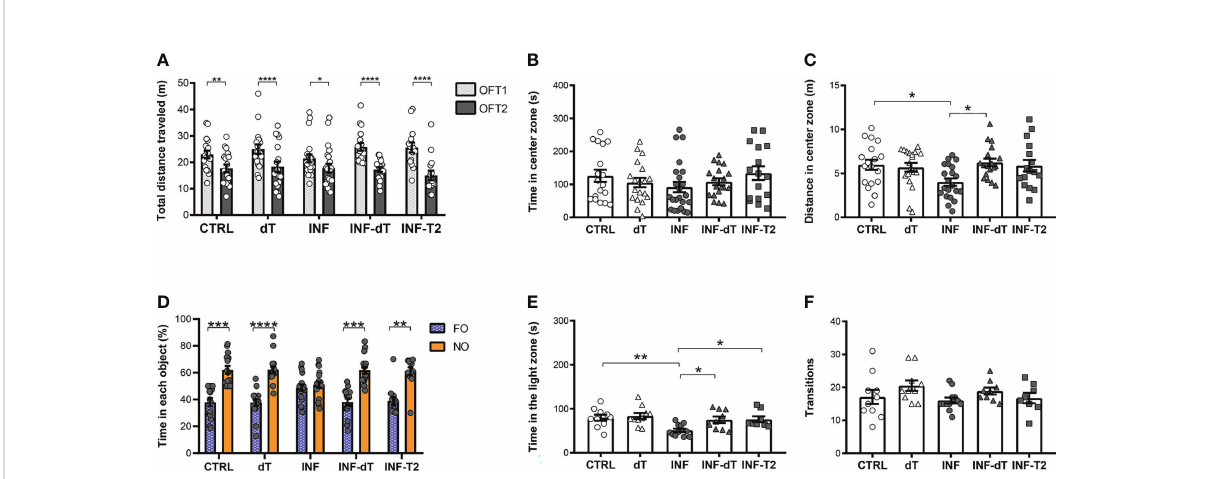
FIGURE 6 Immunization effect on behavioral performance in different paradigms of health mice and after non-severe experimental malaria (control (CTRL), immunized control with dT vaccine (dT), infected (INF), immunized infected with dT vaccine (INF-dT) and immunized infected with T2 stimuli (INF-T2) mice). (A) Total distance traveled in meters (m) in open fi eld test (OFT1 and OFT2). (B) Time in center zone (seconds, s). (C) Distance in center zone (m) in fi rst session of OFT. (D) Time in objects in percentage (%) in test session in the NORT. (E) Time in the light zone (s). (F) Numbers of transitions between light and dark side in light/dark task. Data points are identi fi ed as individuals ’ values. Columns represent mean ± S.E.M. Two-way RM ANOVA/Bonferroni was used for intragroup comparison of different sessions (n=15-22/group) and different objects (n=13-19/group). Two-way ANOVA was used for intergroup comparison of the same sessions (n=15-22/group). One-way ANOVA/Bonferroni was used for comparison of CTRL/INF, CTRL/INF-dT, CTRL/INF-T2, INF/INF-dT e INF/INF-T2 (n= 8-23/group). The p-values between CTRL and INF-dT and INF-T2 were non-signi fi cant. *p<0.05; **p<0.01;